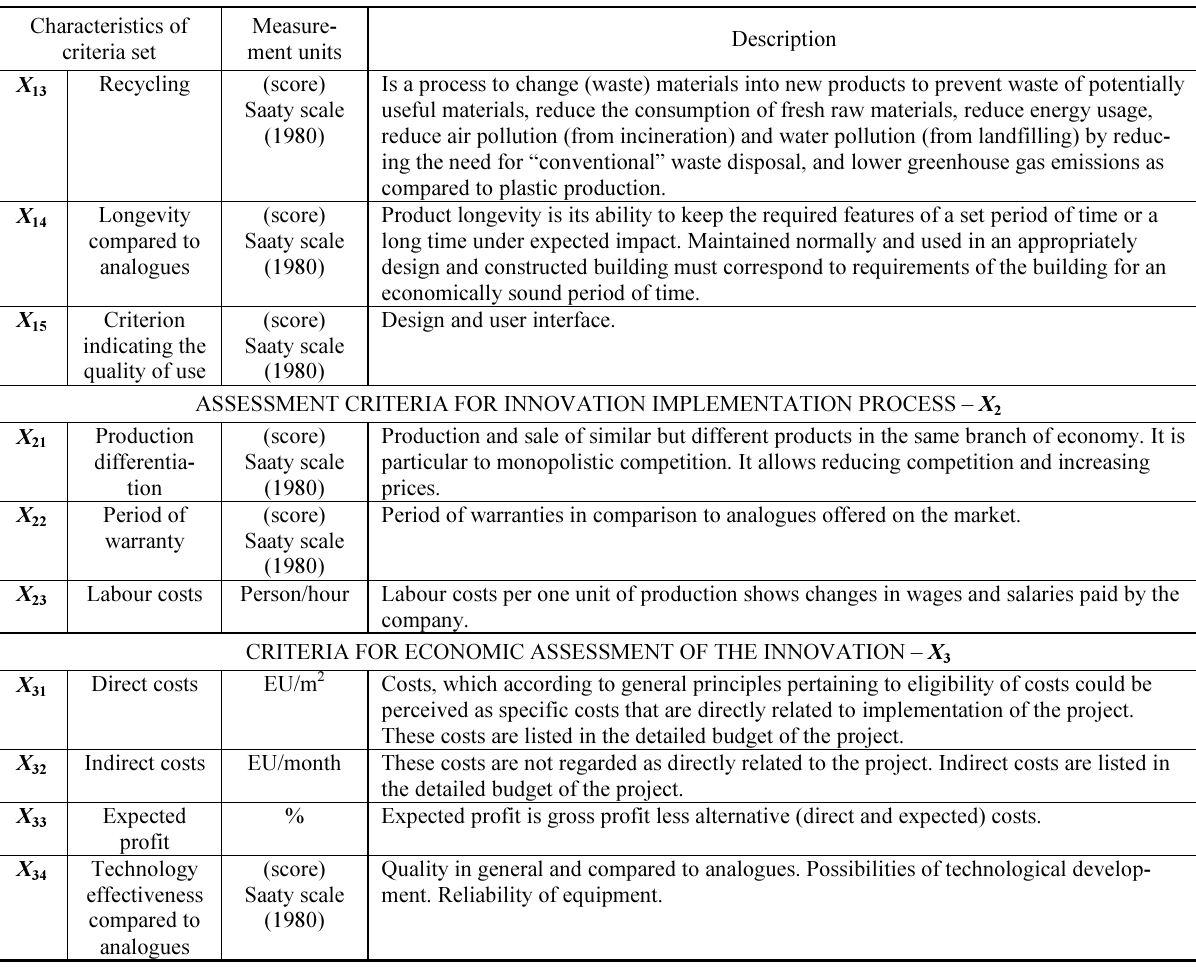
Table 2. AHP method: scale for assessment of qualitative criteria (Saaty 1980)